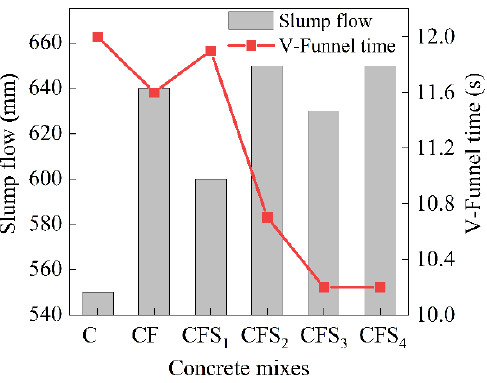
Figure 9. The slump flow and V-funnel time of SCC, adding FA and SF [8].